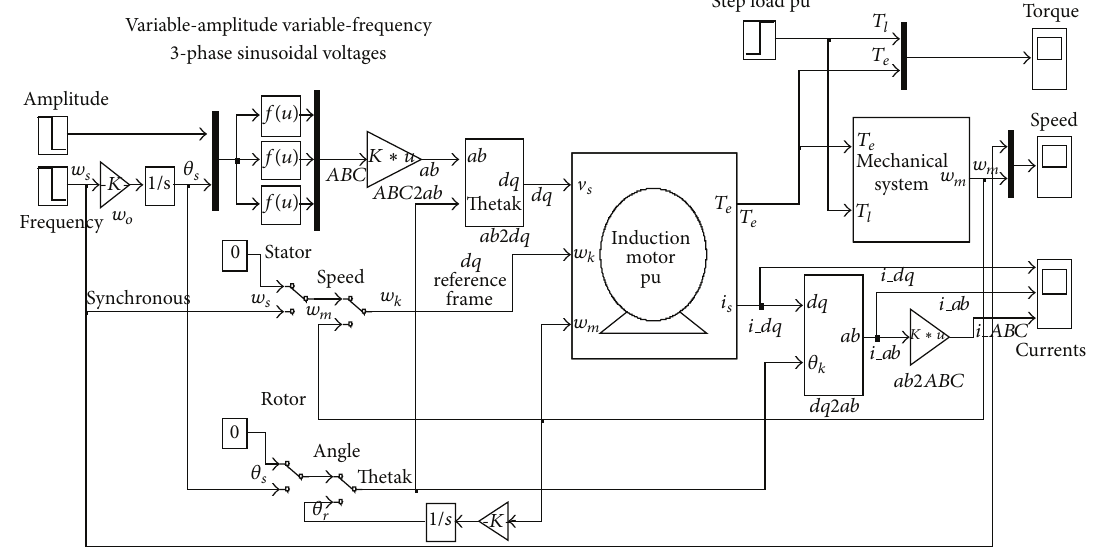
Figure 2: Mathematical modeling of 3-phase induction motor